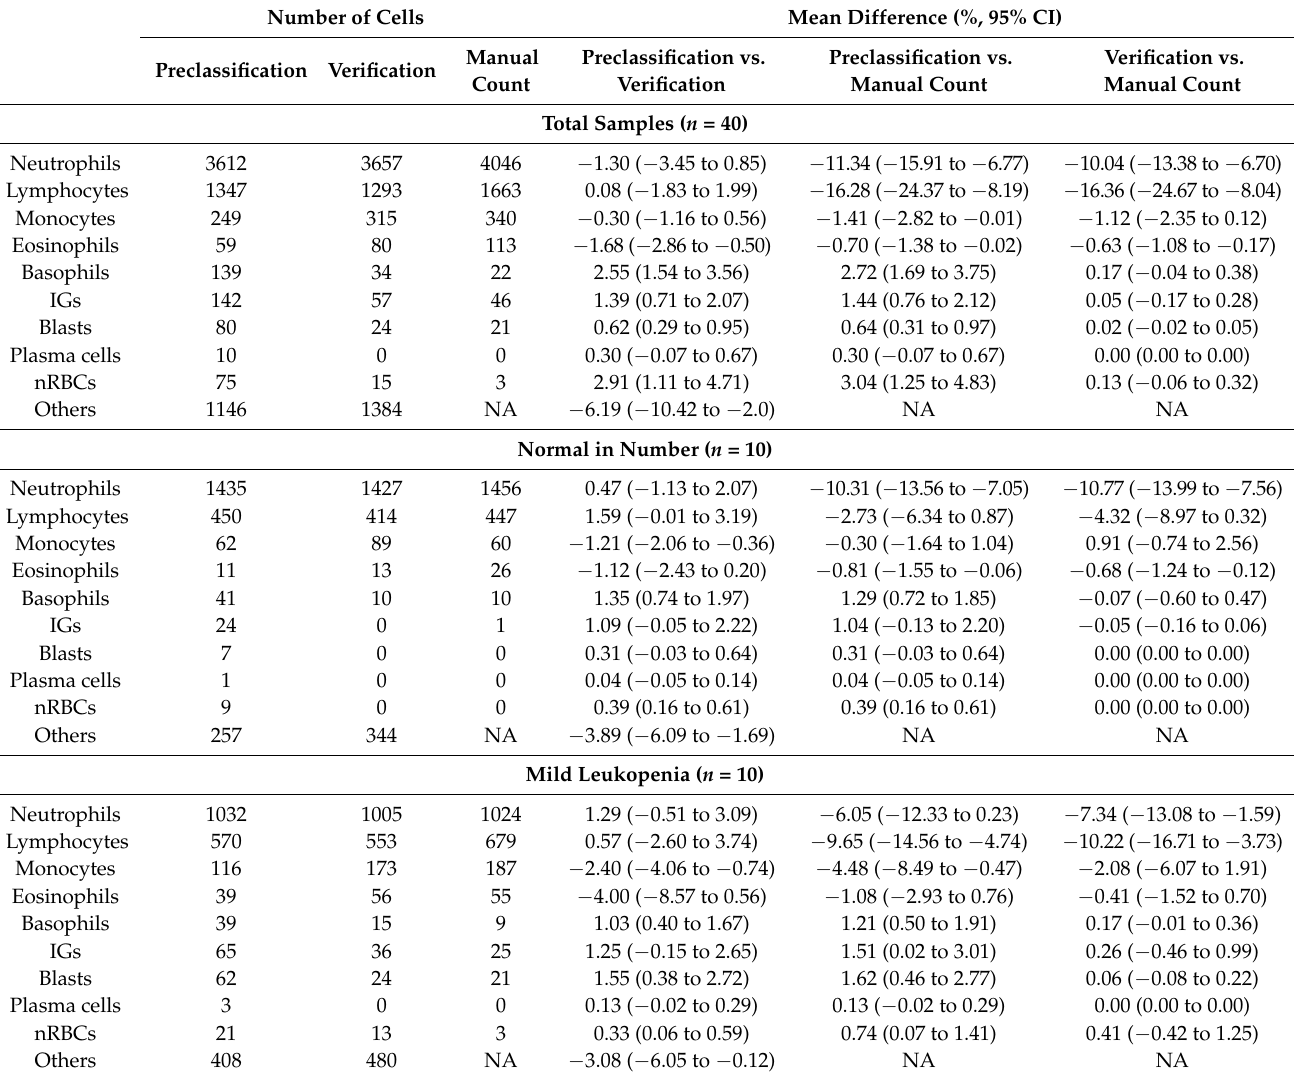
Table 4. Comparison of WBC differentials by DI-60 and manual